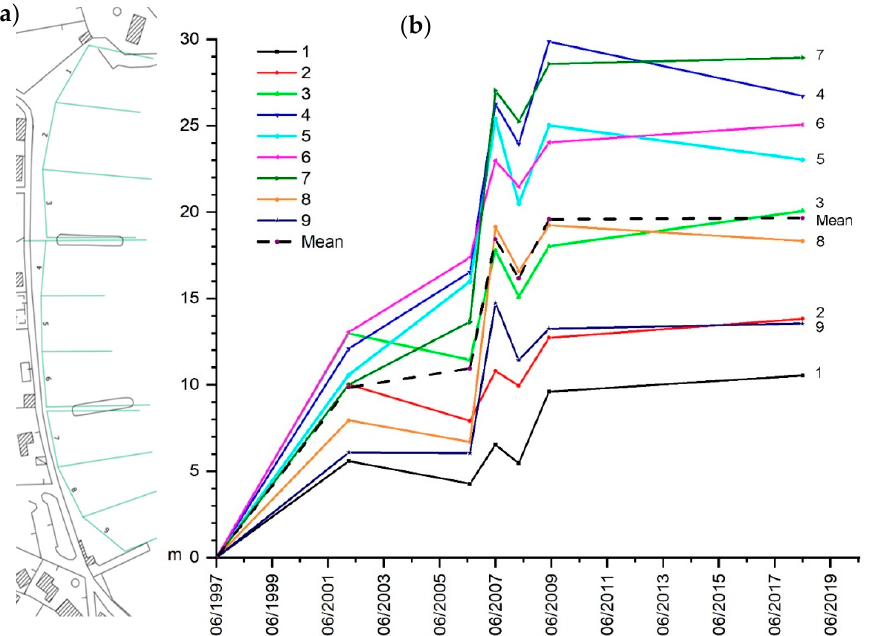
Figure 7. Location of sectors ( a ) and sectors and total mean beach width evolution ( b ) from 1997 to 2018. First nourishment 1999; second nourishment 2006–2008. Table 2. Mean shoreline displacement (m) in the different periods from June 1997 to June 2018 in the 9 considered beach sectors and in the entire beach. Sect. no.